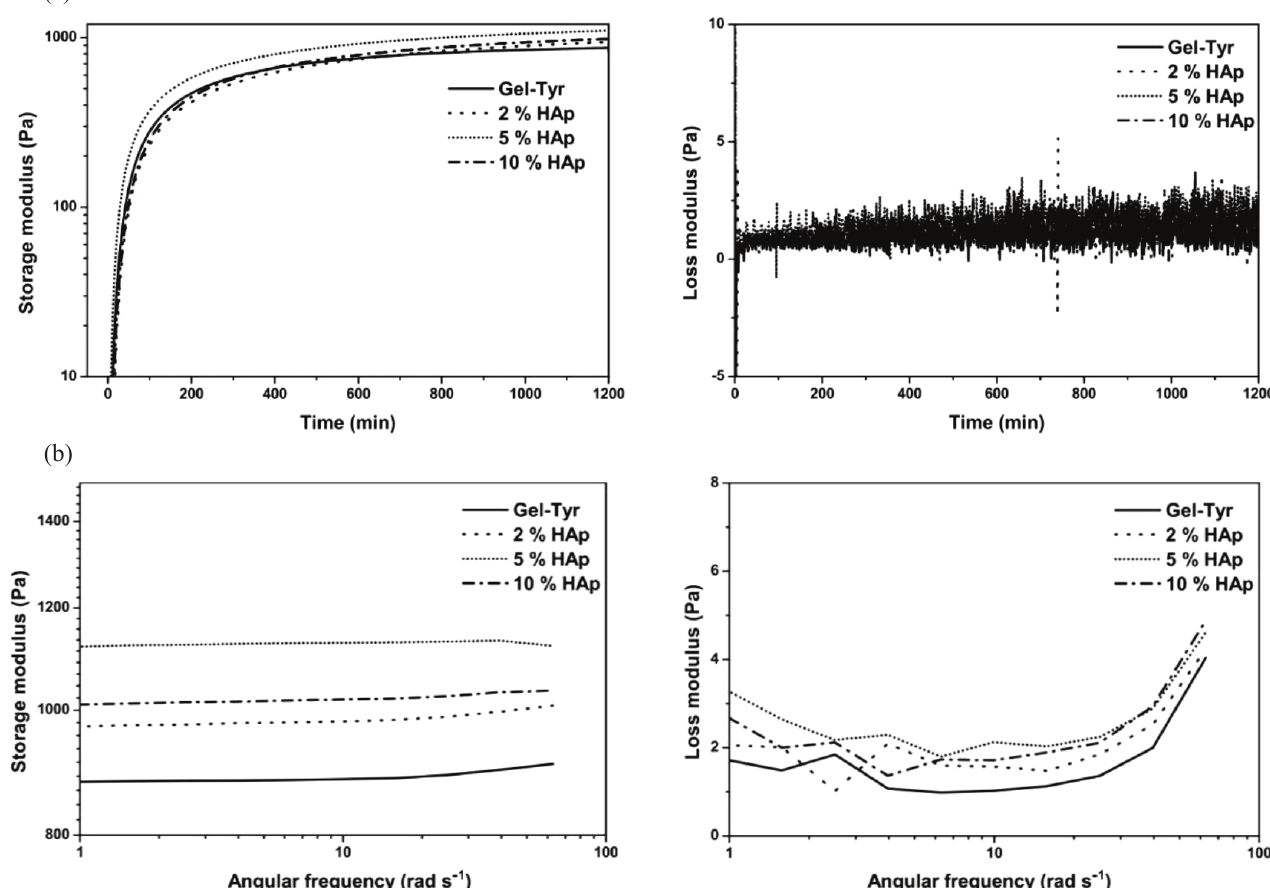
Fig. 6 – Rheological properties of gelatine (Gel-Tyr) and Gel-Tyr/HAp composites with different HAp content (2 % HAp, 5 % HAp, and 10 % HAp): a) gel formation was monitored by time sweep evaluating the storage and loss moduli as functions of time at 1 % strain; b) frequency sweep data at a constant strain of 1 %. Figure represents curves obtained from average data of three individual samples. Relative standard deviations of storage modulus are not included for the sake of